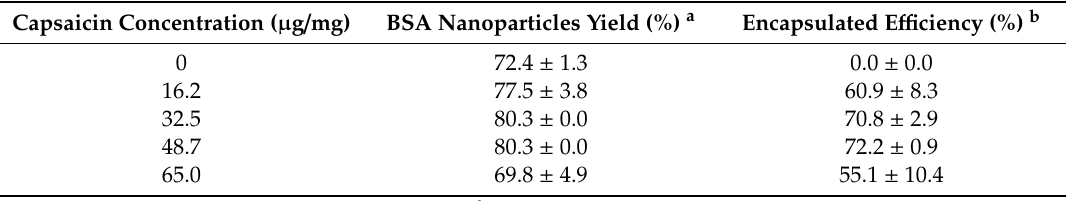
Figure 2. Encapsulated capsaicin in nanoparticles with respect to the concentration. The quantified capsaicin showed a logarithmic tendency (R = 0.9555). Values are means of three experimental replicates ± standard deviations. Table 1. Nanoparticle yield and entrapment efficiency of capsaicin.